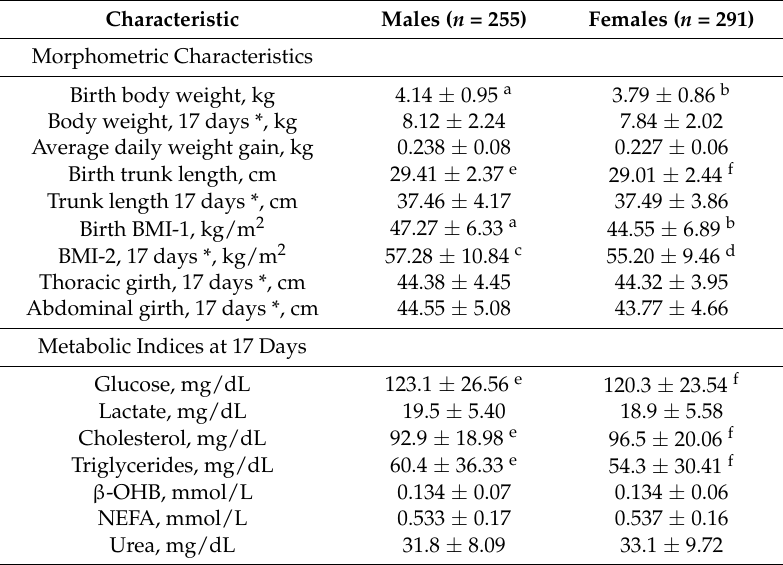
Table 2. Morphometric measurements and metabolic status of lambs, stratified by sex.